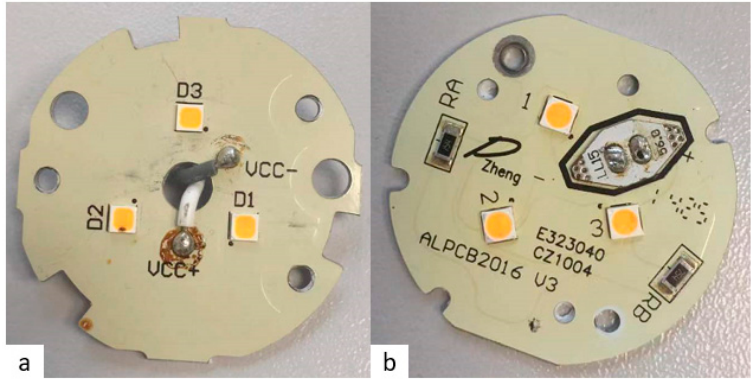
Figure 2. Photographs of LED heads of the spotlights from Samples A ( a ) and B ( b